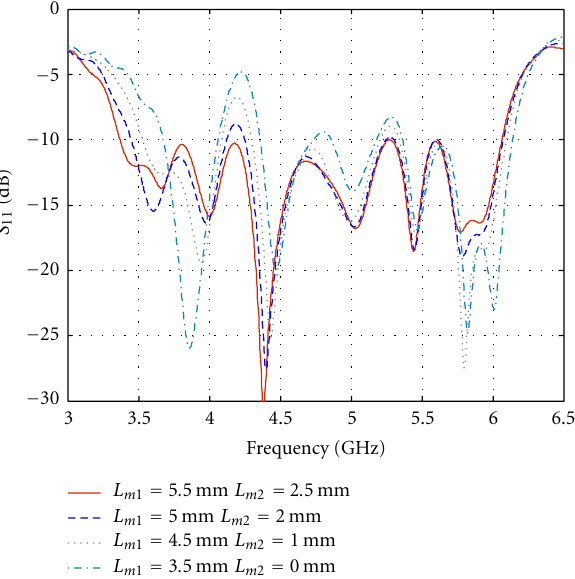
Figure 5: Reflection coe ffi cient of the MSA-BP for di ff erent L m 1 and L m 2